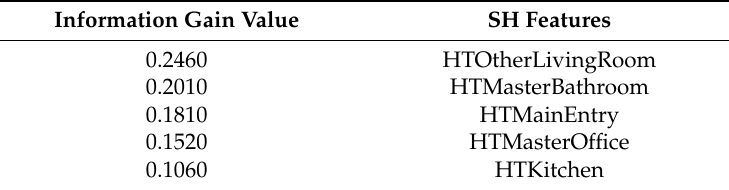
Table 19. InfoGain method predictions for indoor methanol in IAQ 2